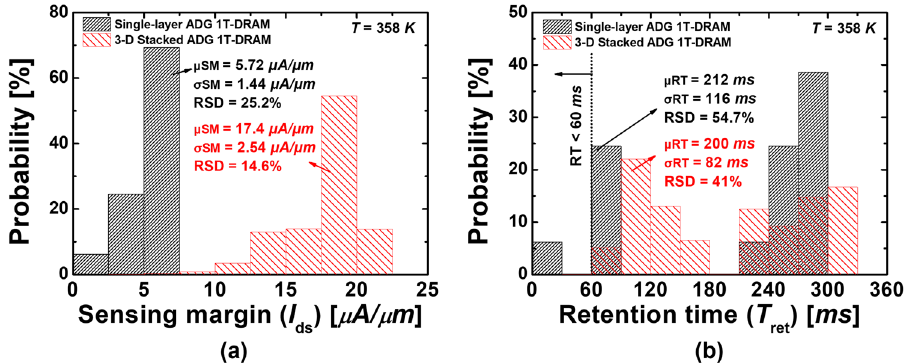
Figure 6. Histograms of ( a ) the SMs and ( b ) the RTs obtained from the proposed single-layer 1 T-DRAMs’ and 3-D stacked 1 T-DRAMs’ 4000 samples with the proposed GBs